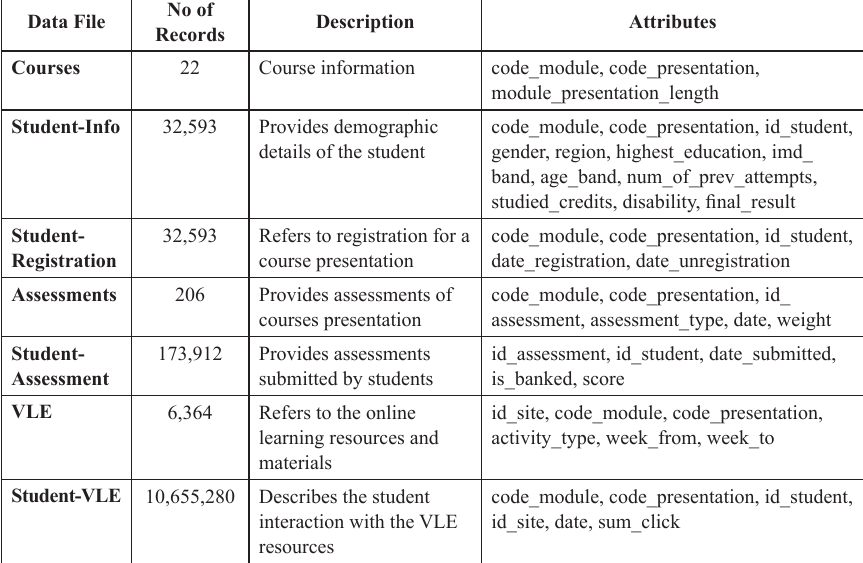
Table 1. The OULAD database